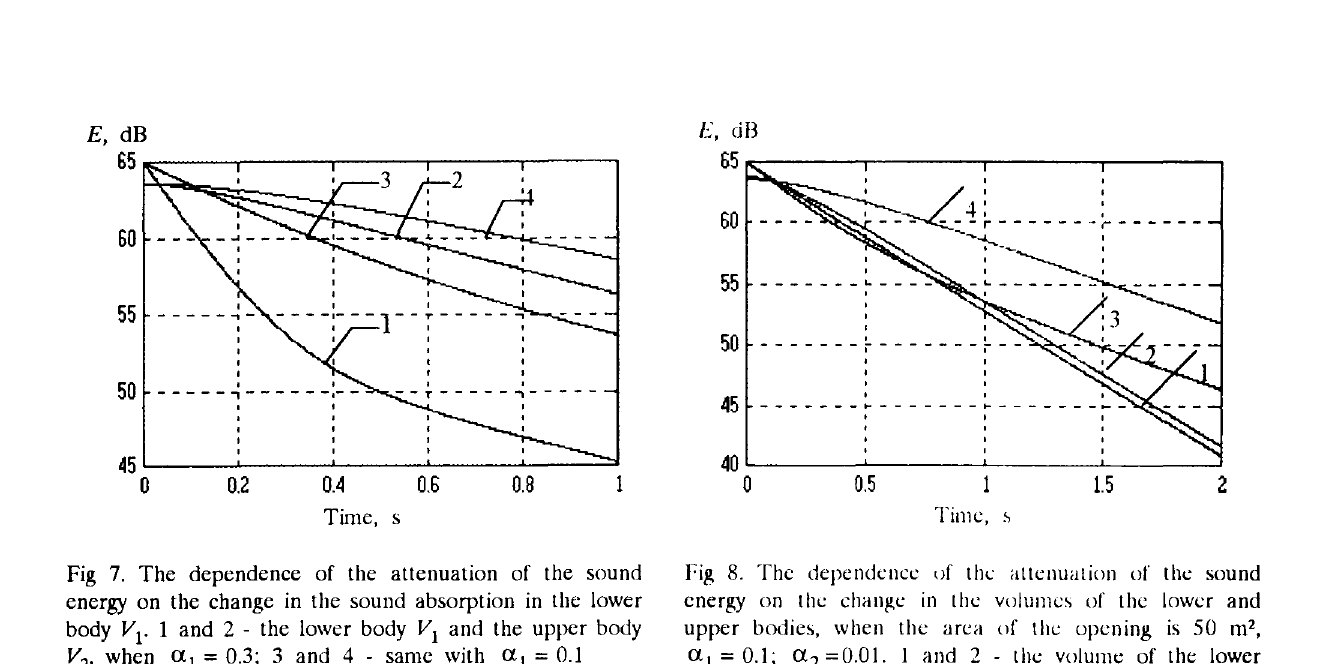
Fig 8. The dependence uf the attenuation of the sound energy on the chan~e in the volume' of the lower and upper bodie~. when the an:a of the opening is 50 m 2, and the upper body 1 a 1 = 0.1; a 2 =0.01. I and 2 - the volunu: of the lower = 748 m 3; 3 body V = R273 m 3 and of the upper body V 2 = 6080 m 1 and V = 2992 m and 4 - V 2 1